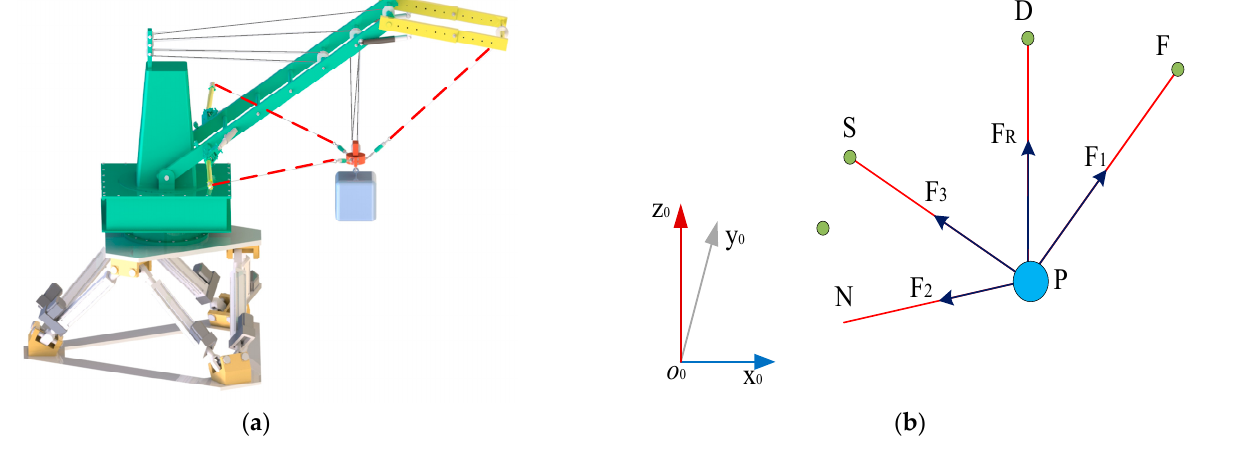
Figure 5. Schematic diagram of statics model: ( a ) schematic diagram of three-dimensional statics model; ( b ) stress analysis diagram of two-dimensional statics model.